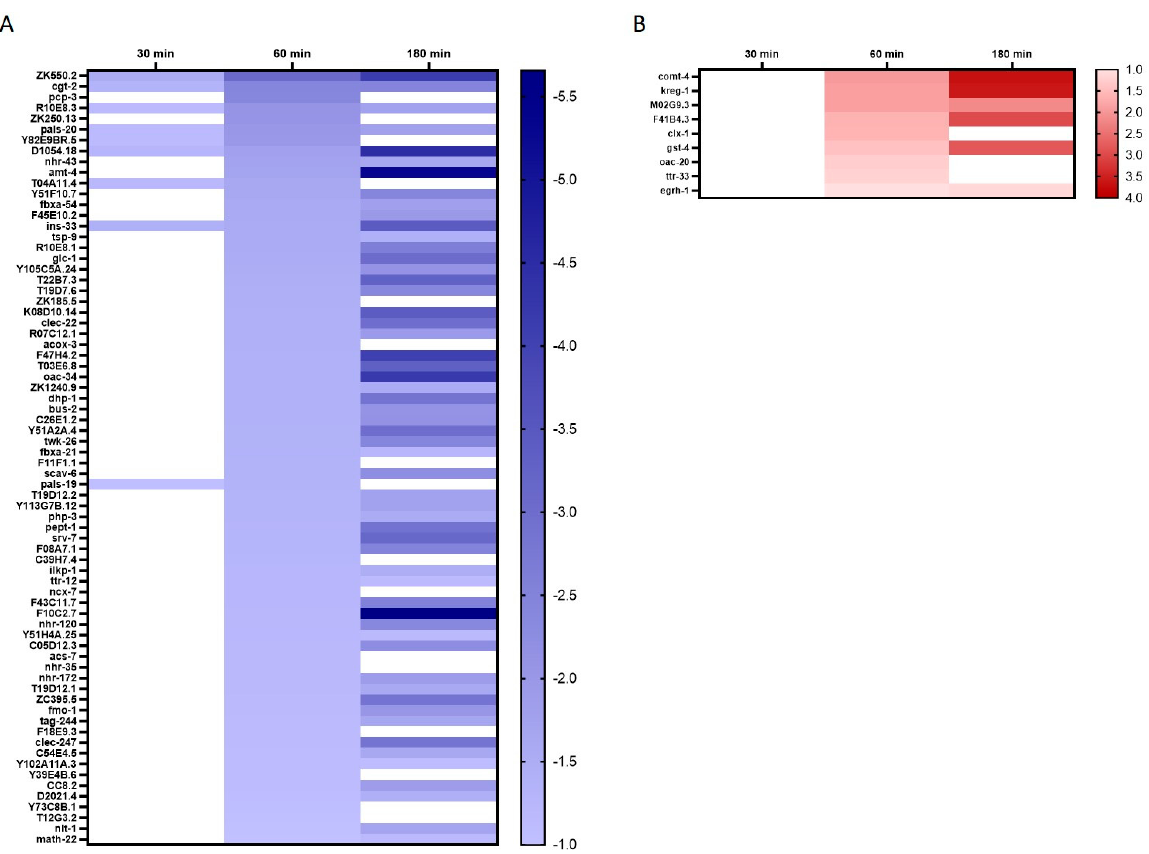
Figure 4. Overview of all DEGs in 0 min vs. 60 min MnCl 2 exposed wild-type C. elegans and their fold changes at 30 min and 180 min compared to non-exposed worms. ( A ) Increased and ( B ) decreased fold changes, analyzed using DESq2. Data are shown as differential expression log2 ratios.